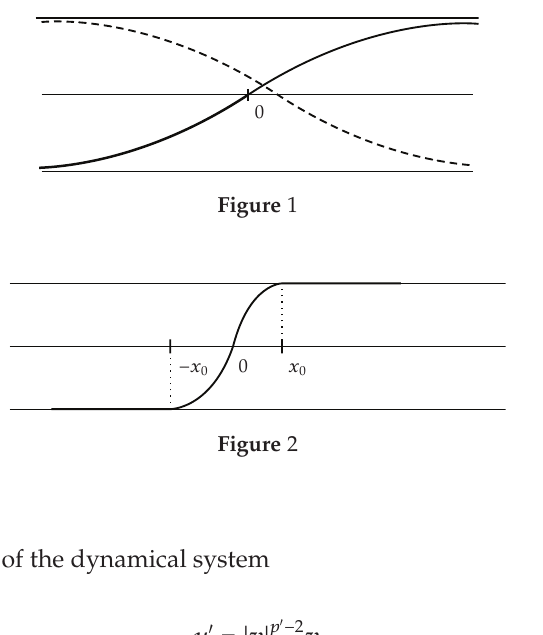
In the language of the dynamical